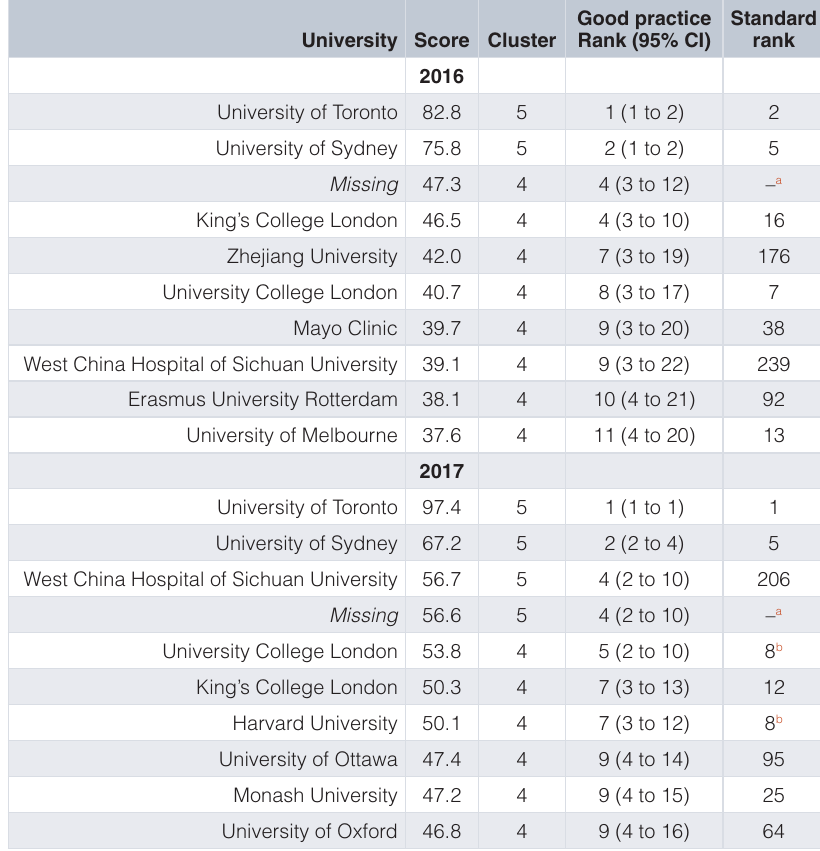
Table 3. Top ten ranking universities in 2016 and 2017 for our good research practice table. Universities are ordered by their score in each year. The cluster column is the median cluster from the Bayesian model, with ‘5’ the highest cluster. The rank is the median rank and 95% bootstrap confidence interval in brackets. The standard rank is based on counting each university’s annual papers.